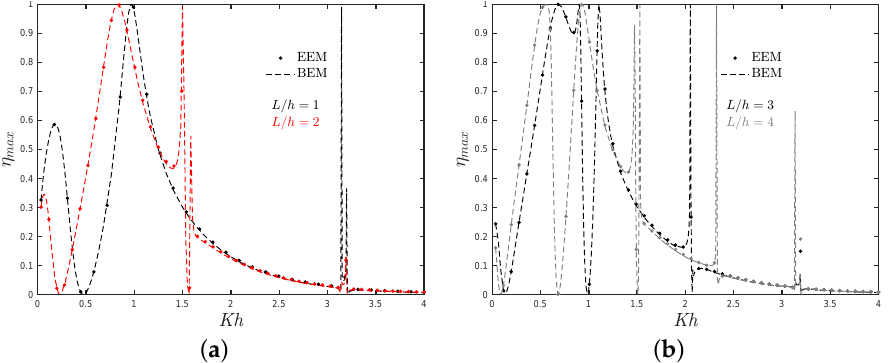
Figure 13. The influence of the length of the gap between the rear and reflecting walls L / h on the maximum hydrodynamic efficiency η max versus the non-dimensional frequency Kh with a 1 / h = a 2 / h = 1/8, b / h = 1 and w 1 / h = w 2 / h = 1/8 for ( a ) L / h (= 1 and 2 ) and ( b ) L / h (= 3 and 4 ) .